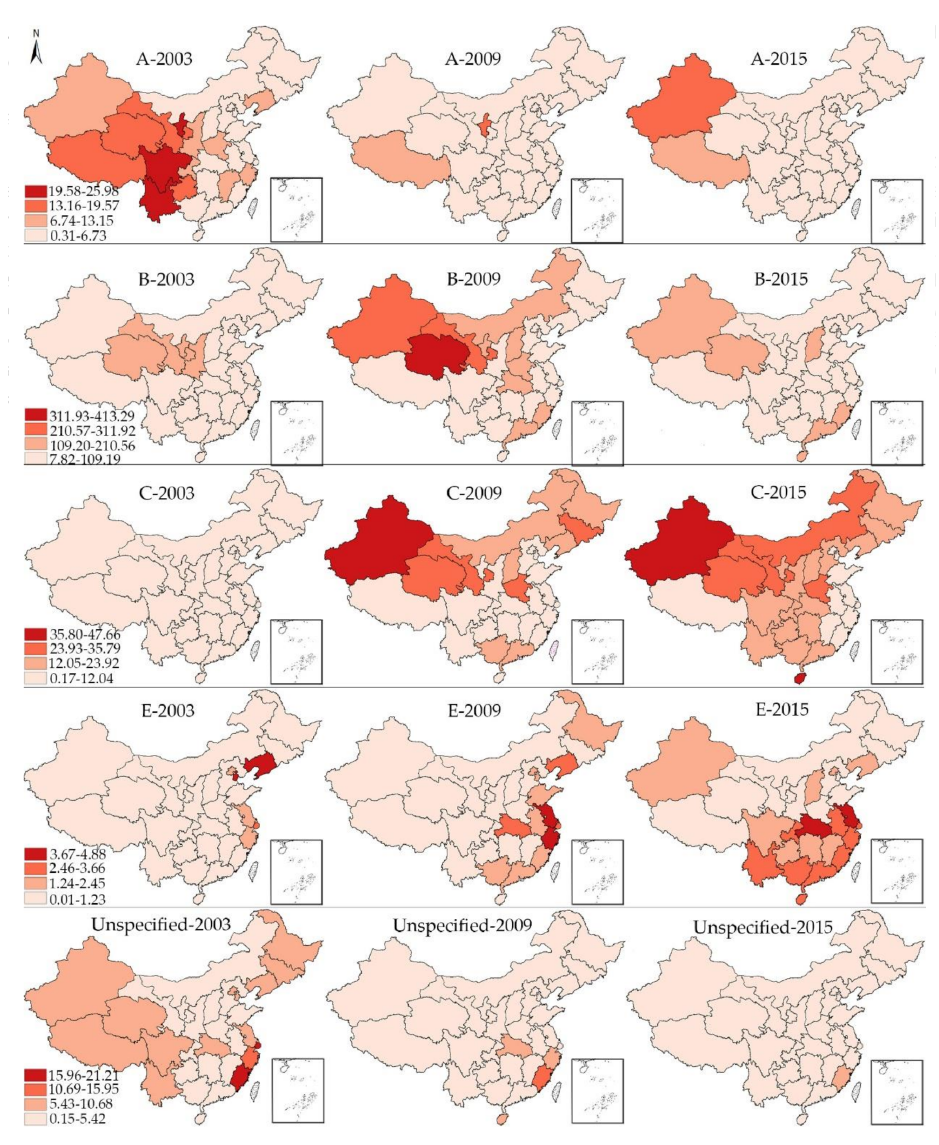
Figure 3. The hierarchy maps of the incidence rate of all types of viral hepatitis in 2003, 2009,